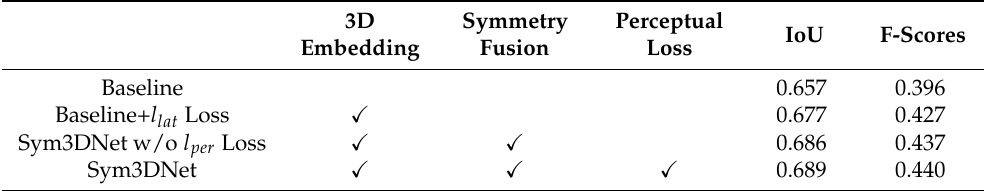
Table 1. The effect of the symmetry fusion module and perceptual loss in our proposed network in terms of IoU and